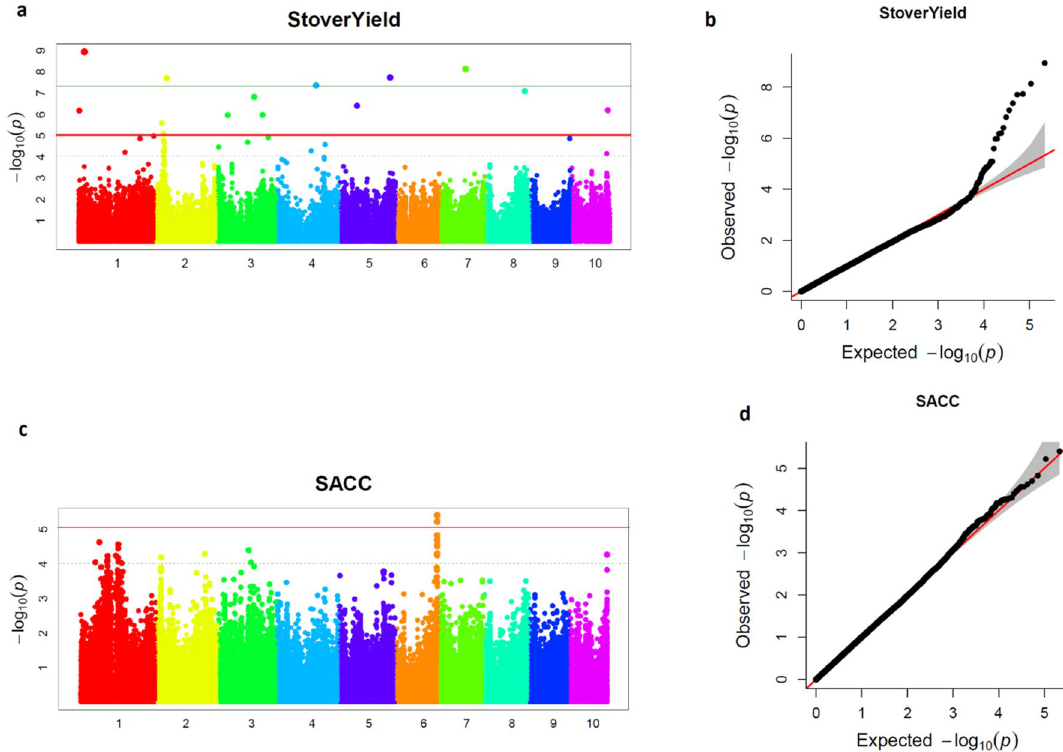
Figure 2. GWAS of stover yield and saccharification efficiency in a maize MAGIC population. ( a ) Manhattan plot of the GWAS mixed linear model for Stover Yield. Single-nucleotide polymorphisms (SNPs) above the red horizontal line surpassed the p value threshold obtained by Bonferroni’s modification approach. ( b ) Quantile– quantile (Q–Q) plot of the GWAS mixed linear model for stover yield. ( c ) Manhattan plot of the GWAS mixed linear model for saccharification efficiency (SACC). Single-nucleotide polymorphisms (SNPs) above the red horizontal line surpassed the p value threshold obtained by the modification of Bonferroni approach (8.07E−06); ( d ) Q-Q plot of the GWAS mixed linear model for